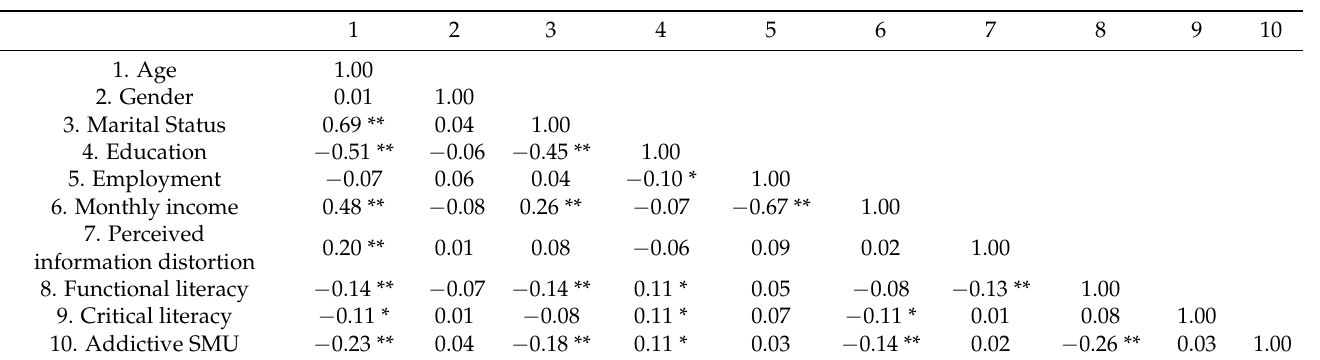
Table 2. Correlation between variables (N =